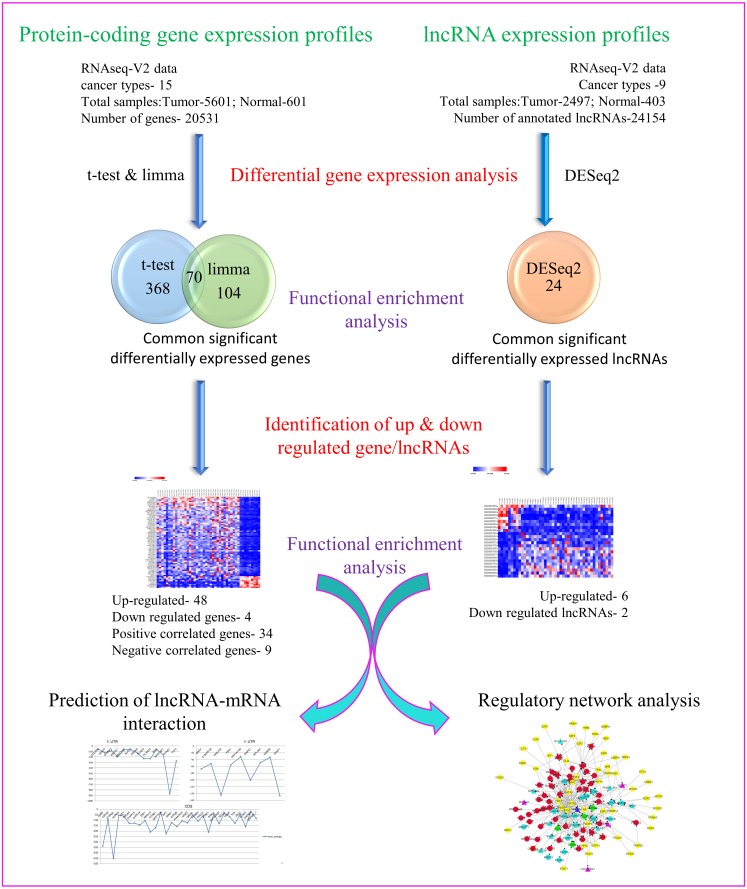
Flowchart depicting different steps used and narrowing down genes as seen through corresponding number of coding and non-coding genes.